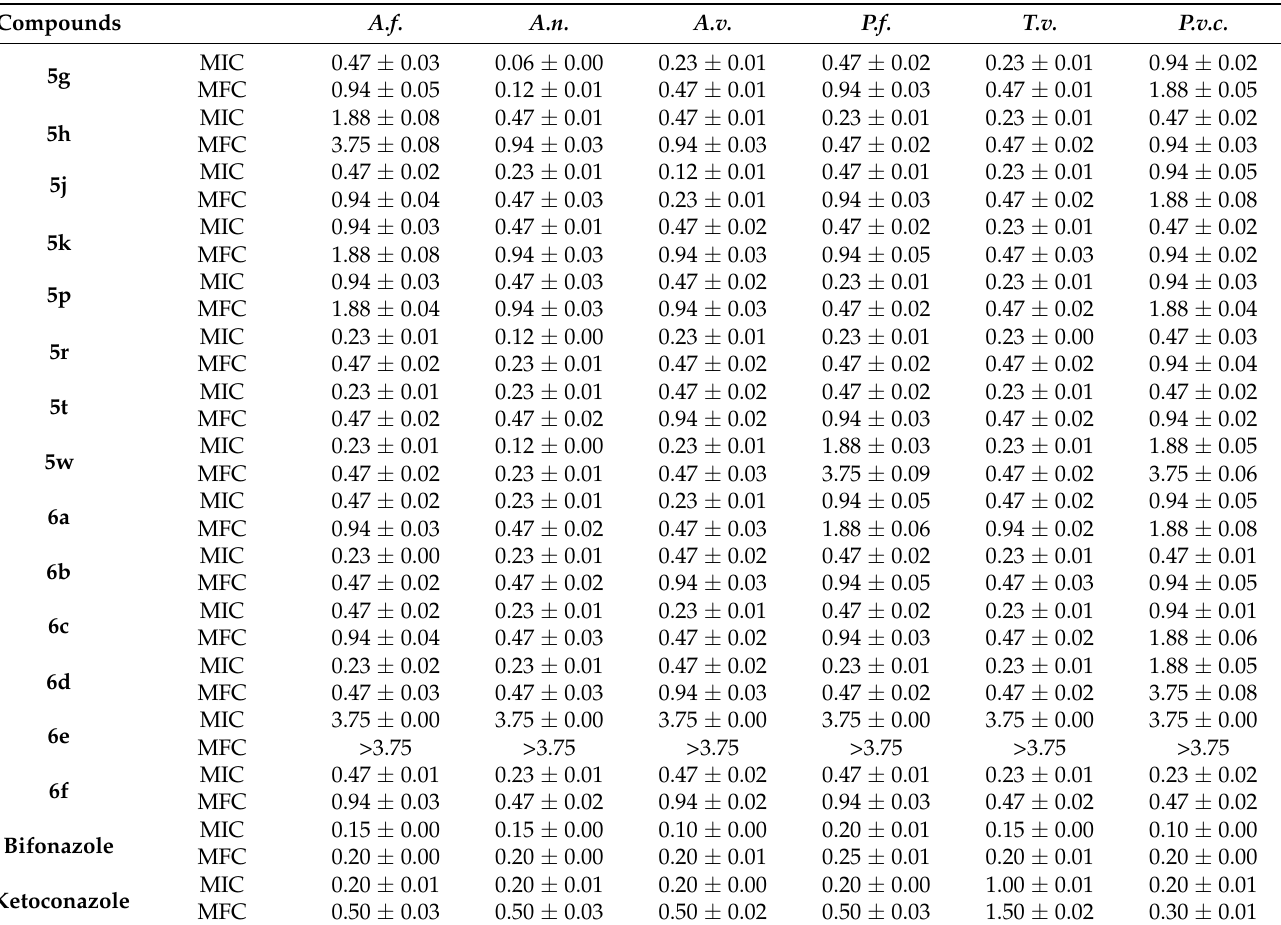
Table 5. Antifungal activity of methylindole derivatives (MIC and MBC in